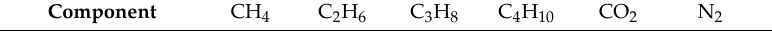
Table 3. Average composition of natural gas.